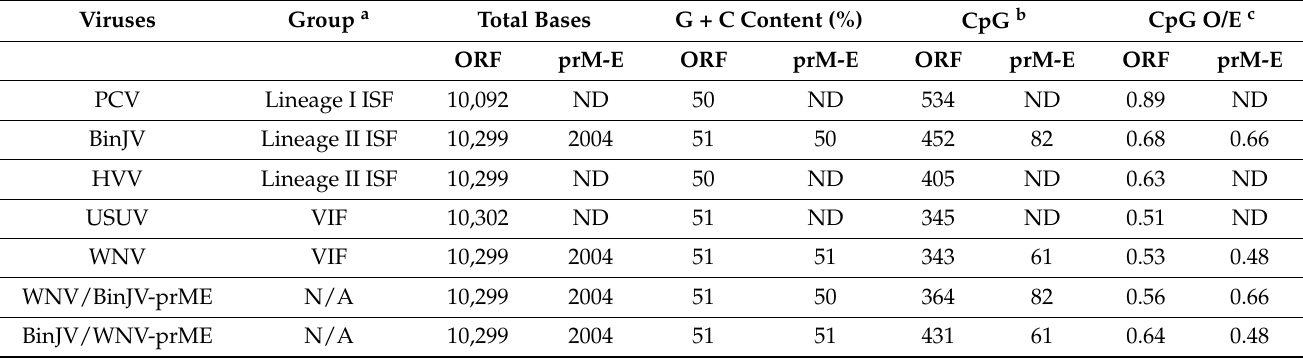
Table 2. CpG dinucleotide frequencies of viruses used in this